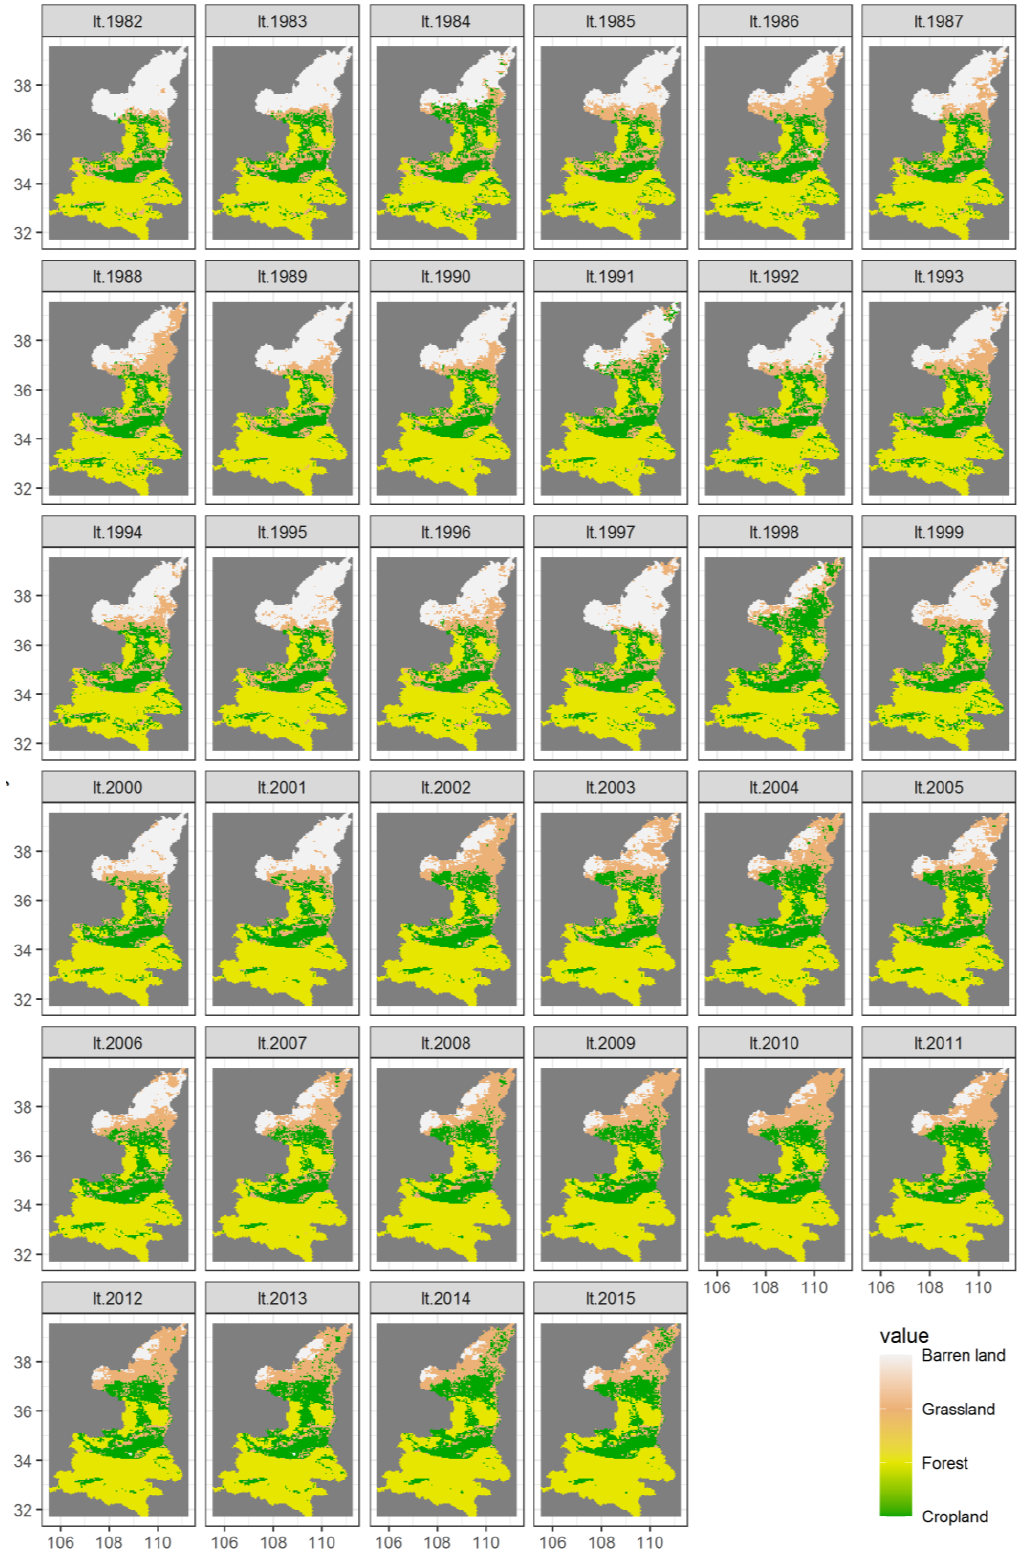
Figure 17. A spatial set of maps showing land cover during 1982–2015 (“lt.1982” denotes the land cover in 1982, and so on).